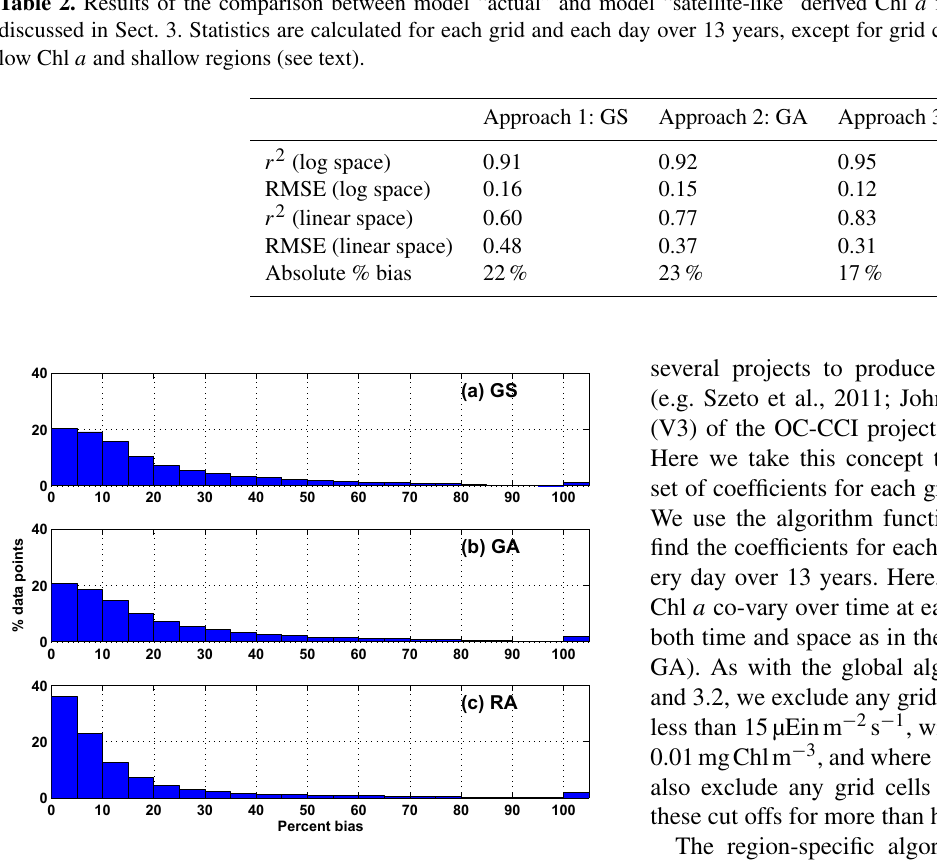
Figure 7. Distribution of percentage of model output (time and space, about 140 million “data” points) with absolute percent error between model derived Chl a and model actual Chl a for (a) global subsampled approach (GS), (b) global all output approach (GA) and (c) region-specific approach